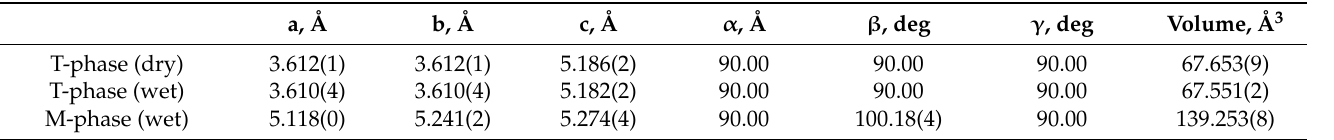
Table 2. Parameters of unit cells of T- and M-phases in the ZrO 2 + 3 mol% Y 2 O 3 nanopowder with different degrees of moisture.